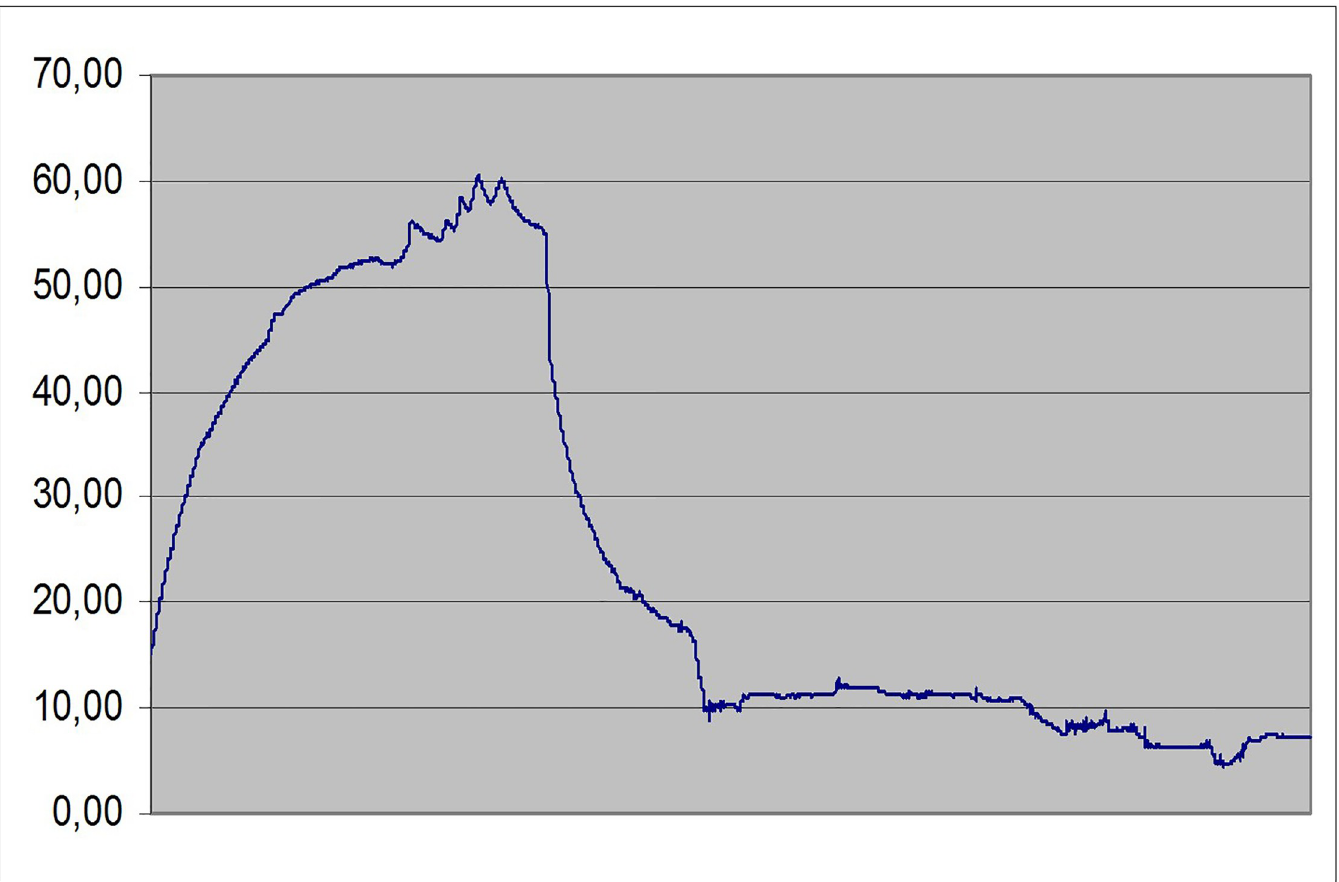
Fig 7. Blood pressure in the great saphenous vein (GSV) at the ankle level during arterial support pump inflations. Patient in a supine position. Increase of pressure during 10 inflations and fast decrease upon cessation of support. The pressure increase in the GSV proved stasis of venous blood. It may suggest also increase in venous